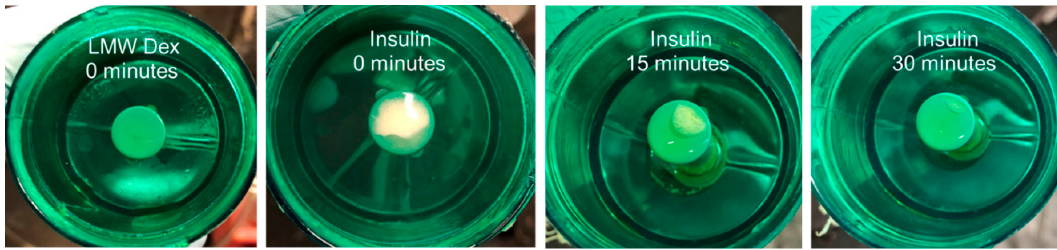
Figure 8. Images of the jet nebulizer platform shortly after a period of agitation for both LMW dextran and Insulin solutions as a function of time.